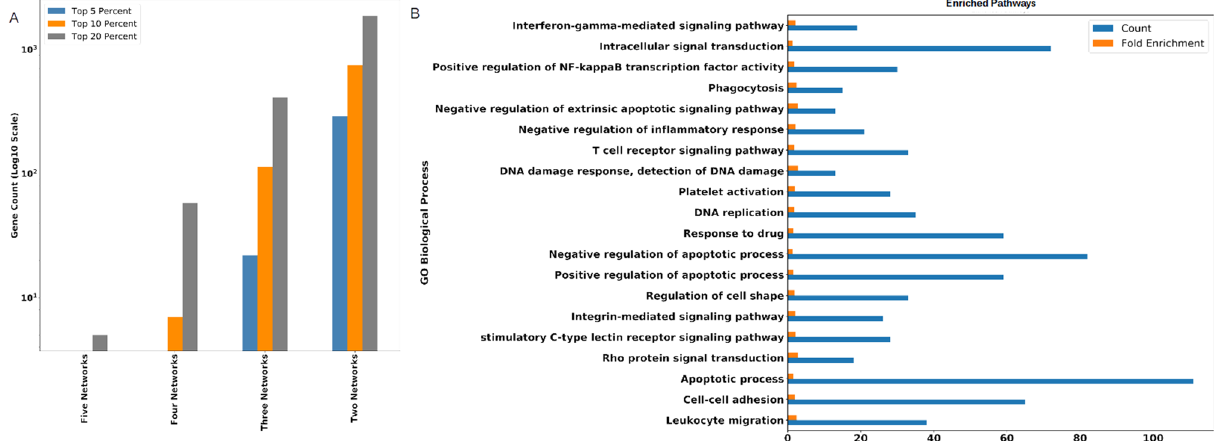
Figure 3. Identification and analysis of hub genes. ( A ) top 5%, top 10%, and top 20% hub genes identified for each dataset that are identified by five, four, three, and two networks. ( B ) GO biological processes enriched in 2,351 hub genes with False Discovery Rate <